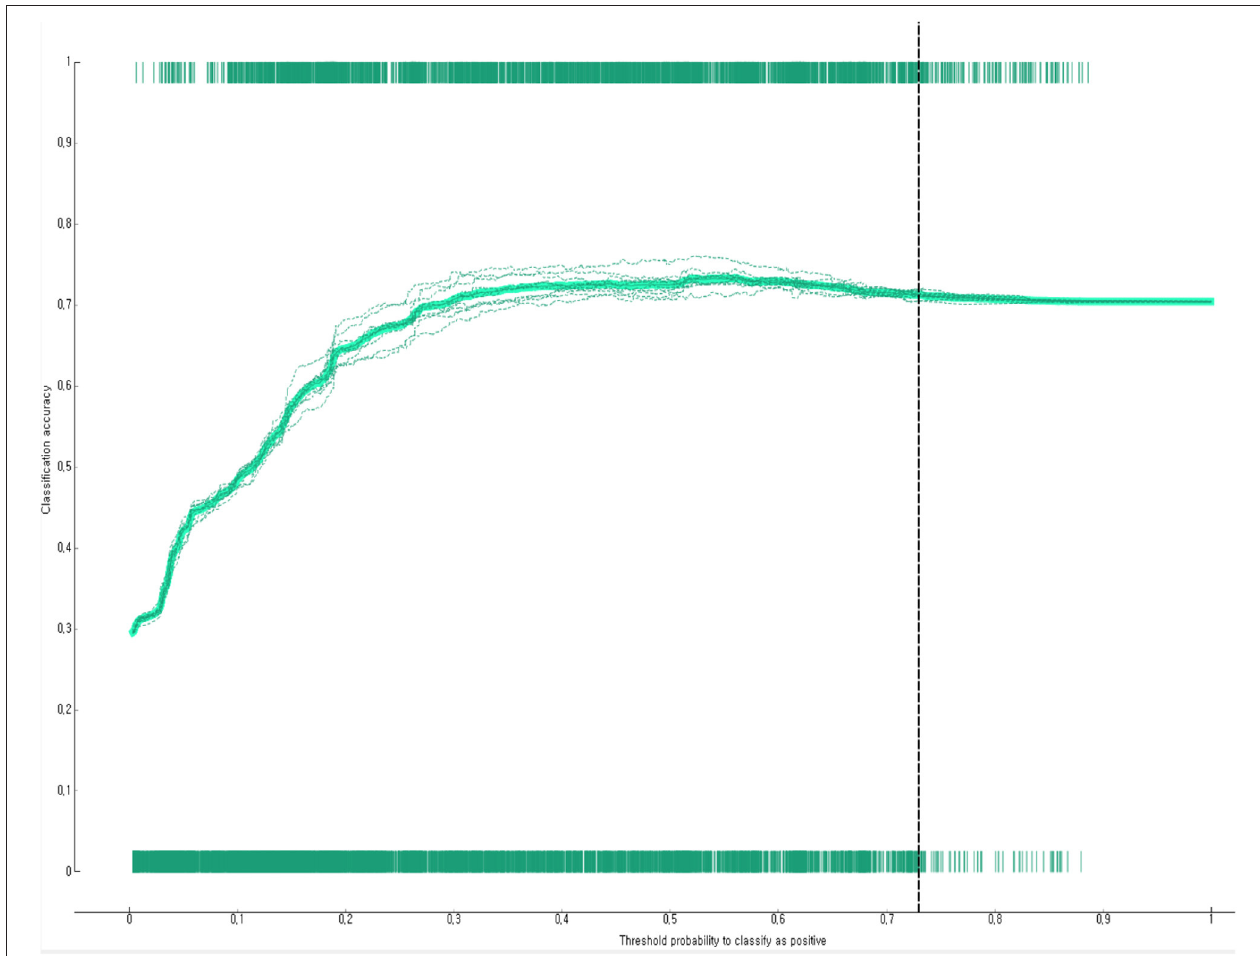
FIGURE 9 | Classification accuracy of the Bayesian nomogram for predicting the depressive disorders of female older adults living alone.